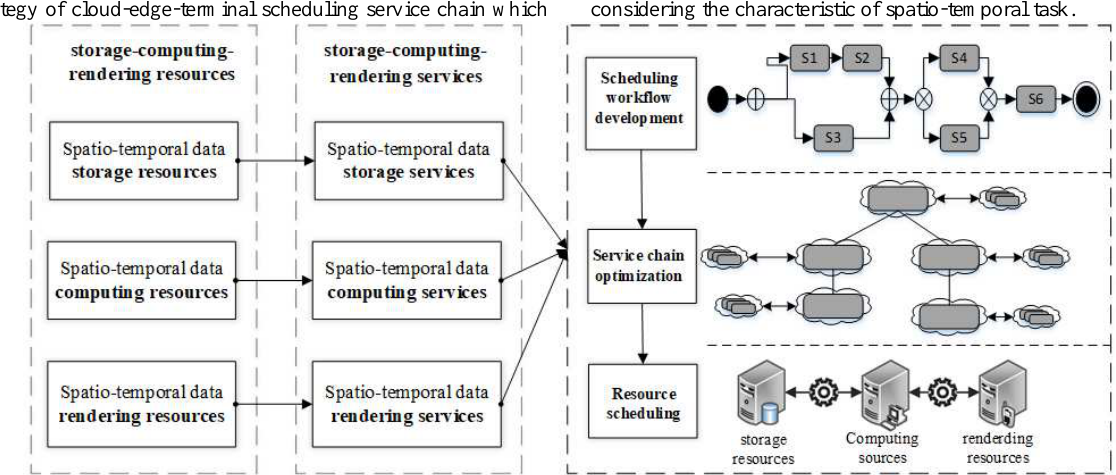
Figure. 2 Task driven multi-granularity storage-computing-rendering resources collaborative scheduling mechanism